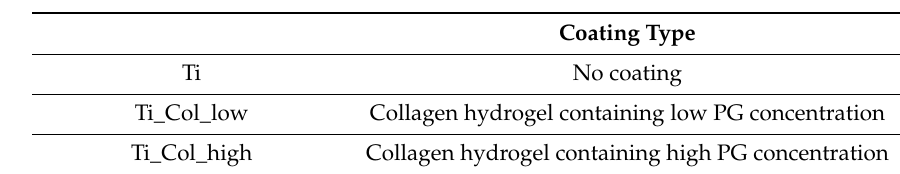
Table 2. Coatings